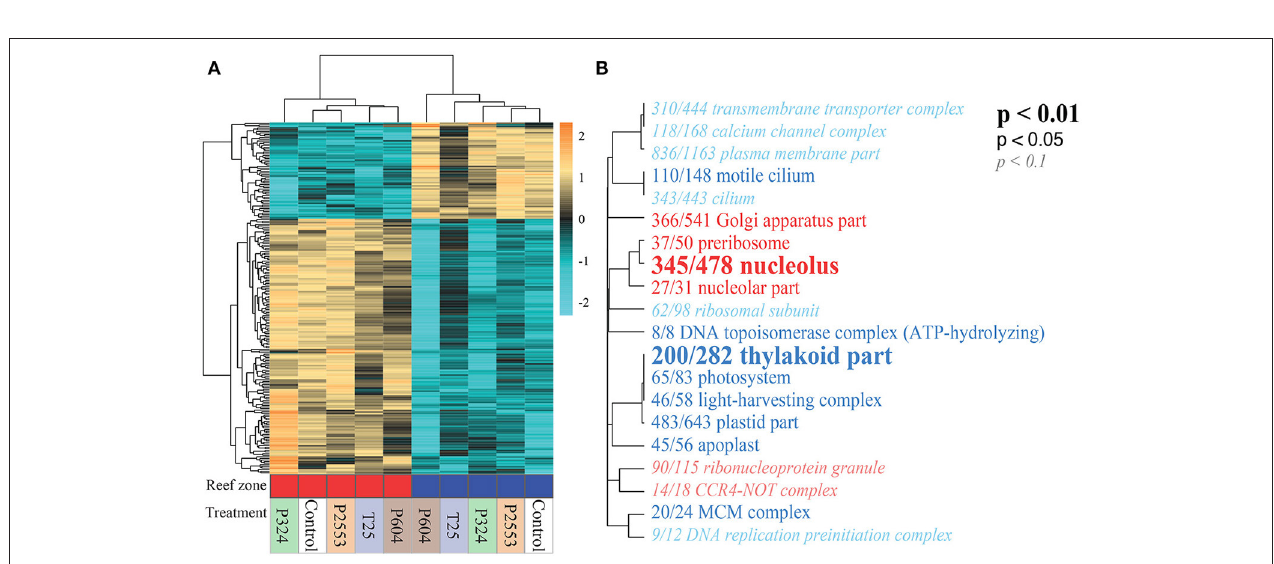
FIGURE 4 | Differentially expressed genes (DEGs) of Symbiodinium goreaui across reef zones and treatments. (A) Heatmap for the top 300 DEGs for reef zone where each row is a gene and each column is a unique transcriptome library. The color scale is in log 2 (fold change relative to the gene’s mean) and genes and samples are clustered hierarchically based on Pearson’s correlation of their expression across samples. Red and blue blocks indicate that libraries originated from nearshore and forereef corals, respectively. Treatment conditions are noted below the bar (T25 = 25.01 ± 0.14 ◦ C, 515 ± 92 µ atm; Control = 28.16 ± 0.24 ◦ C, 477 ± 83 µ atm; P324 = 28.14 ± 0.27 ◦ C, 324 ± 89 µ atm; P604 = 28.04 ± 0.28 ◦ C, 604 ± 107 µ atm; P2553 = 27.93 ± 0.19 ◦ C, 2553 ± 506 µ atm). Hierarchical clustering of libraries (columns) demonstrates strong reef zone differences in gene expression. (B) Gene ontology (GO) enrichment of the “Cellular component (CC)” category derived from the transcriptomic differences across reef zones. Dendrograms depict sharing of genes between categories (categories with no branch length between them are subsets of each other), with the fractions corresponding to proportion of genes with an unadjusted p < 0.05 relative to the total number of genes within the category. Text size and boldness indicate the significance (Mann–Whitney U tests) of the term. Blue categories are enriched in forereef S. goreaui while red categories are enriched in nearshore S. goreaui . Forereef S. goreaui exhibit enrichment of GO categories associated with